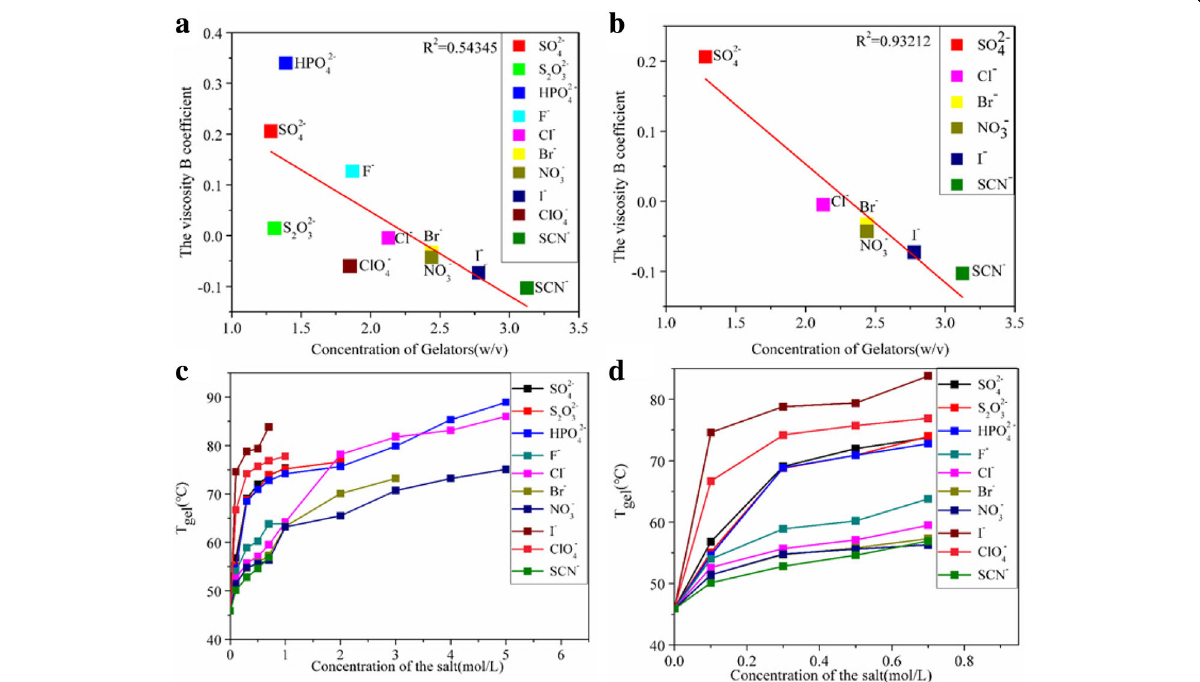
Fig. 2 a CGCs (0.5 M salts) with the viscosity B coefficients. b CGCs (0.5 M salts) except the special points with the viscosity B coefficients. c Plot of the effect of anions (the salt concentration from 0 to 5 M) and T gel of G1 hydrogel as a function of salt concentration. d Plot of the effect of anions (the salt concentration from 0 to 0.7 M) and T gel of G1 hydrogel as a function of salt